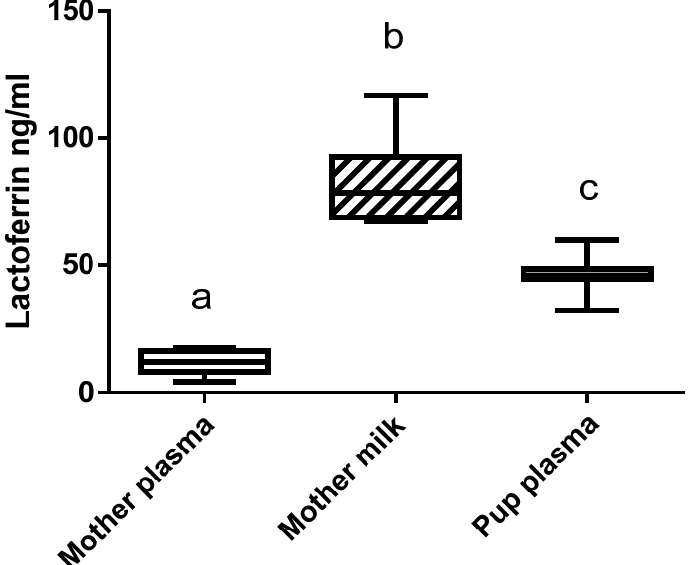
Figure 3. bLF concentration in the plasma and milk of the mothers supplemented with bLF and in pup plasma. Data represented are means ± SEM (groups with different letters are significantly different) ( n = 8 for the mothers and n = 16 for the pups). Each group was compared with the others by a one-way ANOVA followed by a Tukey post hoc test. Means that are significantly different ( p < 0.05) according to the Tukey multiple comparison test have different letters.